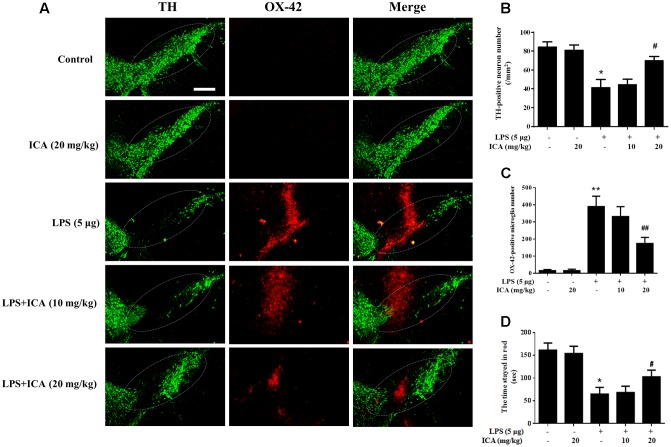
Icariin attenuated LPS-Induced DA neuronal loss and microglial activation in vivo. Rats were given a single intranigral injection of LPS into the SN pars compacta on one side of rat brain followed by daily intragastric administration of ICA for 7 consecutive days. Then, rats were sacrificed and the brains were collected. Double-label immunofluorescence was performed by staining with anti-TH and anti-OX-42 antibodies (green fluorescence represented DA neurons and red fluorescence represented microglia) (A). The “ellipse” presented the area of SN. Scale bar: 200 μm. The number of SN TH-positive neurons (mm2) was counted (B) and the quantification of SN OX-42-positive microglia number was performed (C). Rat behavior changes were analyzed through rotarod test. The time stayed in rod was recorded (D). Results were the mean ± SEM from six rats (n = 6). ∗p < 0.05 or ∗∗p < 0.01 compared with the control group; #p < 0.05 or ##p < 0.01 compared with LPS-treated group.